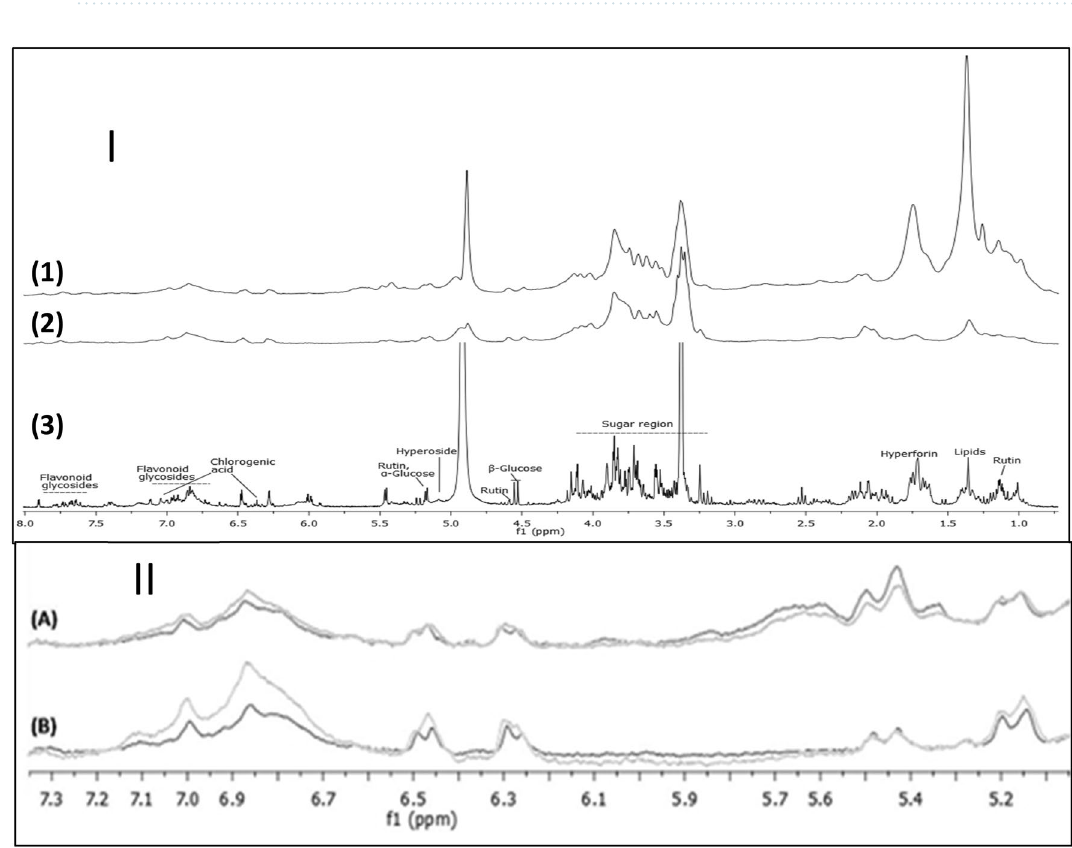
Figure 4. 1H NMR spectra of H. perforatum L. extracts: (I) benchtop NMR (60 MHz) (1—ethanol extract, 2— ethanol–water extract) versus high field NMR (300 MHz) (3) spectra; (II) ethanol (A) and ethanol–water